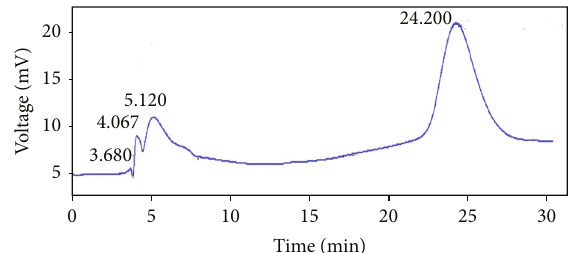
Figure 2: HPLC of isolated flavonoid fraction from Cissus quadran- gularis Linn.